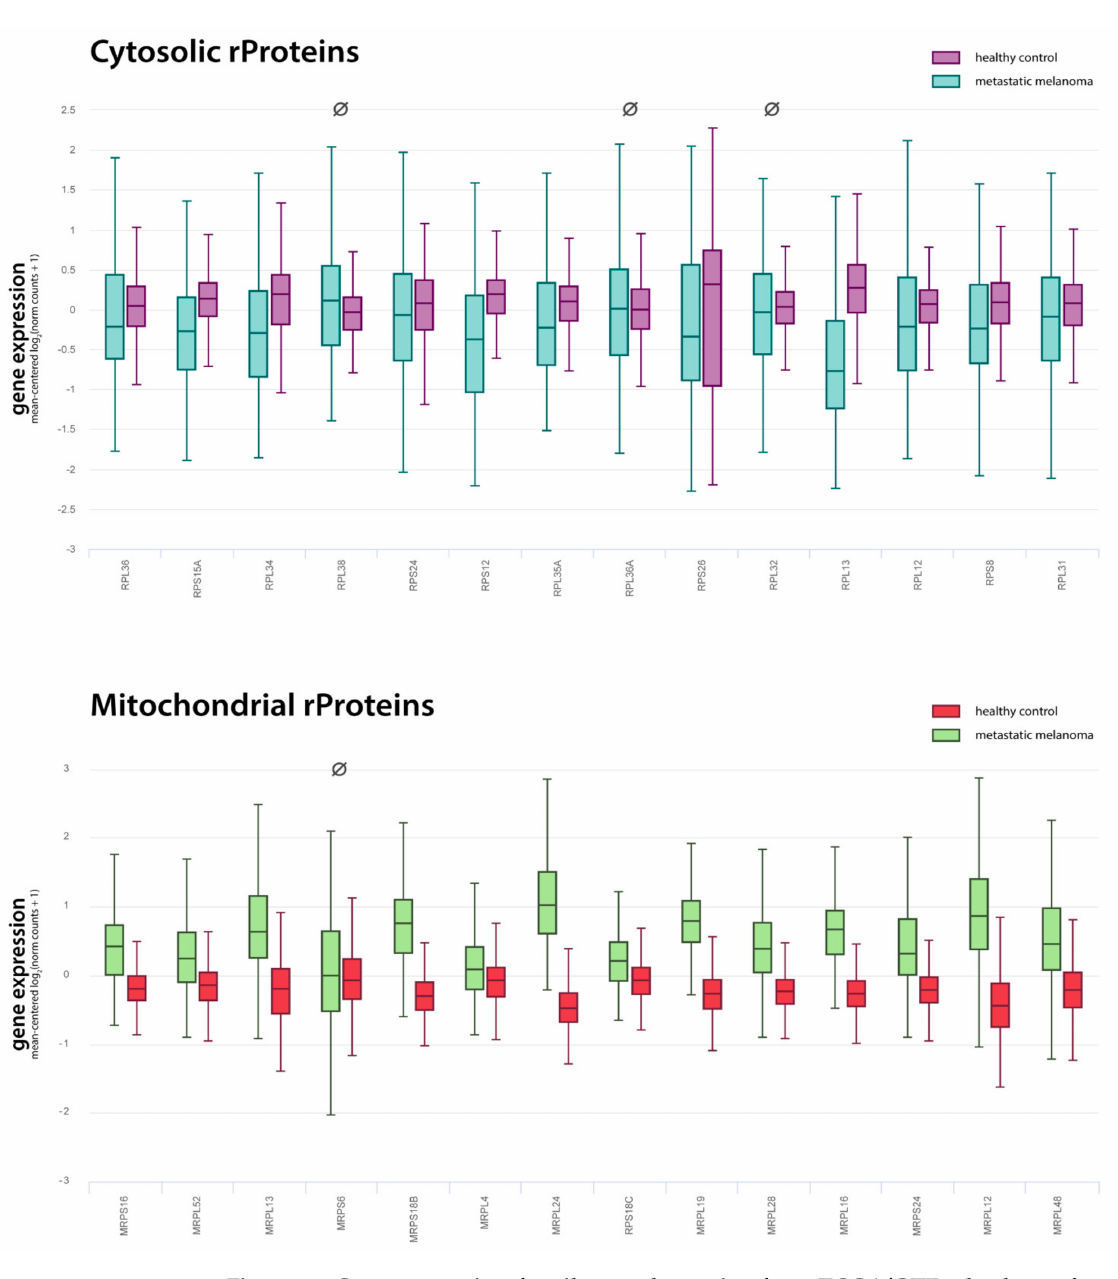
Figure 5. Gene expression for ribosomal proteins from TCGA/GTEx databases for metastatic melanoma samples . The Xena browser was used to filter TCGA samples and keep only the data from Skin Cutaneous Melanoma studies of the metastatic type and with no mutations in the BRAF gene. The final cohort featured 179 tumour samples from TCGA and 557 healthy samples from GTEx, for a total sample size of n = 736. The RNA-Seq expression data are given in units of log 2 RSEM normalised counts, gene-wise mean-centred, and shown as boxplots for the 14 cytosolic (magenta and teal) and the 14 mitochondrial (red and green) rProteins that emerged from the leading edge analysis of microarray data. Overall, 24 out of 28 differential expressions were confirmed by TCGA data, supporting the evidence of a generalised downregulation of the cytosolic rProteins and an overexpression of the mitochondrial ones. The four unconfirmed comparisons are marked with the symbol Ø (see Table 2 for more